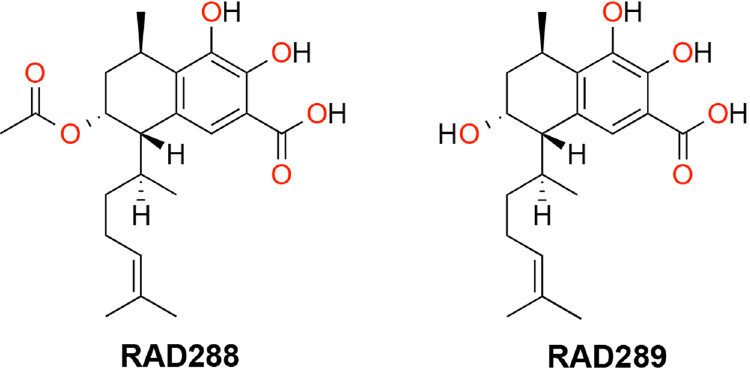
Figure 1. Structure of RAD288 (3-acetoxy-7,8-dihydroxyserrulat-14-en-19-oic acid) and RAD289 (3,7,8-trihydroxyserrulat-14-en-19-oic